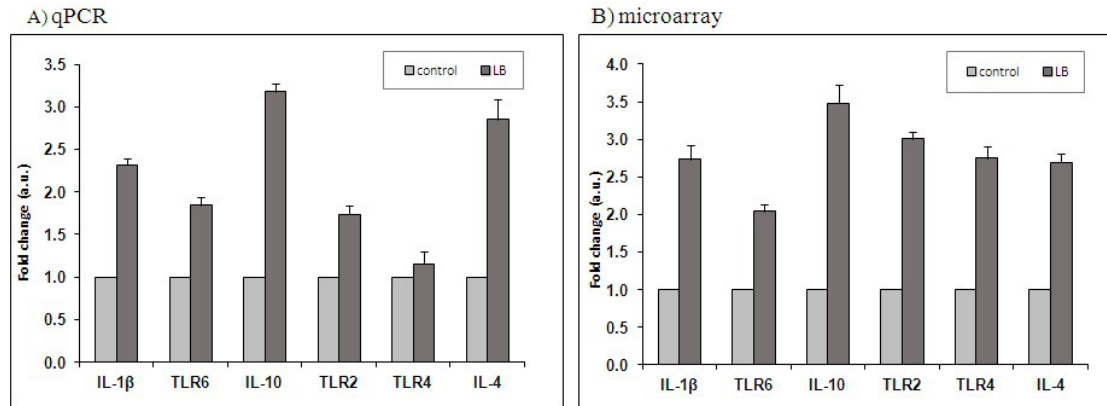
Figure 1. Validation of microarray results by real-time RT-PCR. Gene expression of six selected genes obtained by qPCR ( A ) was compared with that obtained by microarray ( B ). Each experiment was repeated four times ( ) lactobacilli mixture versus ( ) Control cells); n = 4.